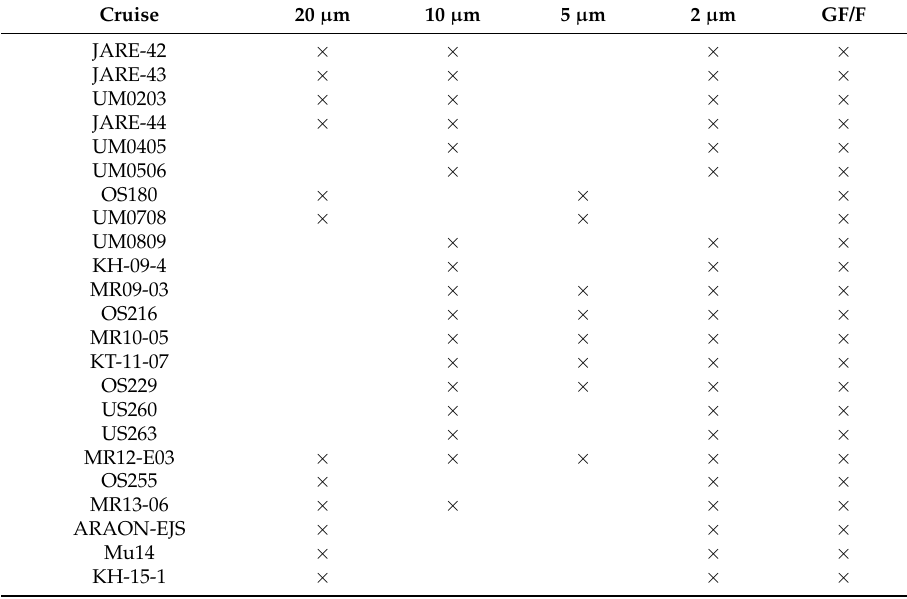
Table 2. Summary of pore size of filters that were used to obtain Chl a size during each